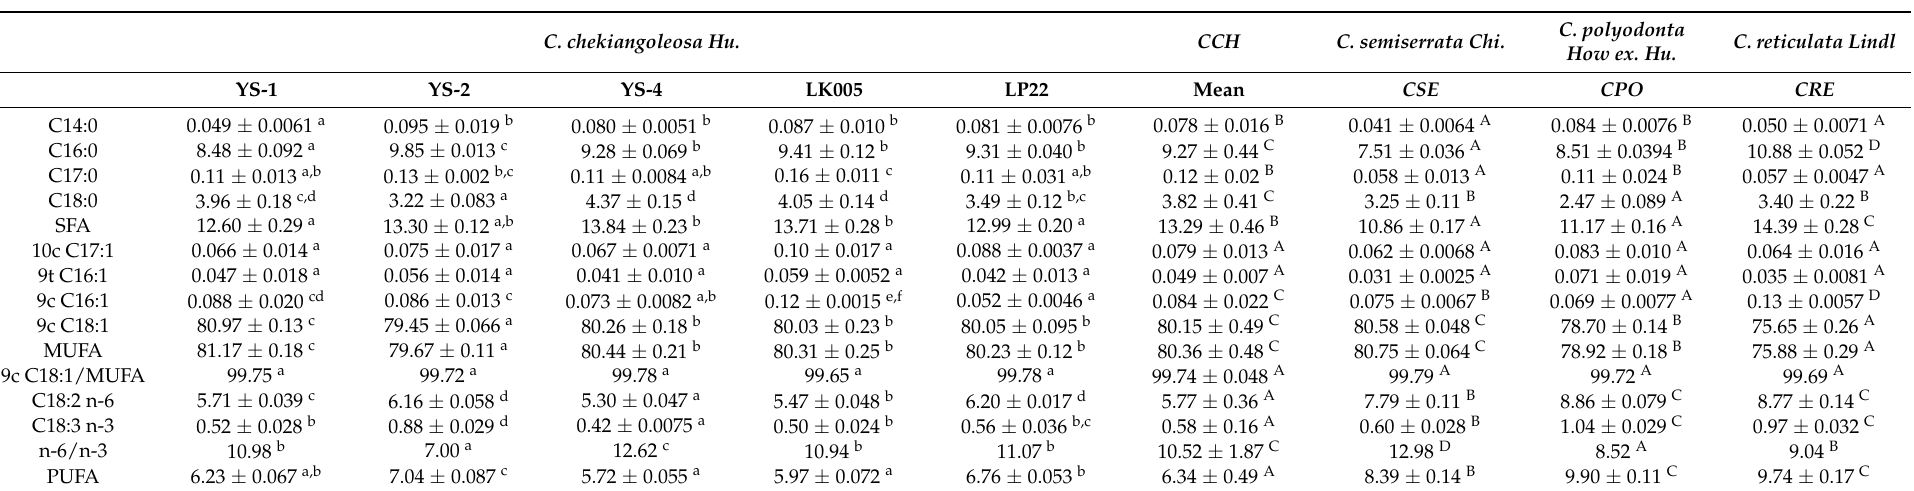
Table 4. Fatty acid composition of four ROC oils